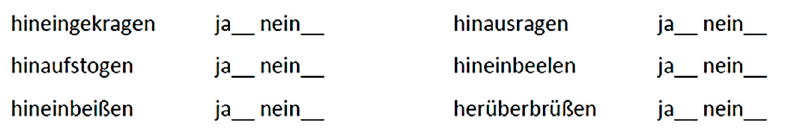
Figure 5. Example from the lexical decision task.